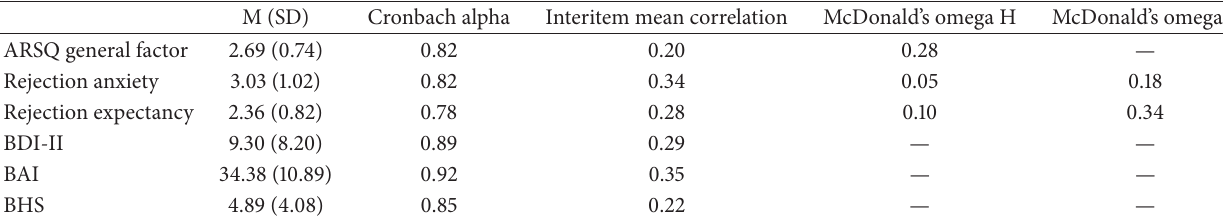
Table 4: Descriptive statistics ( 𝑁 = 774 ).